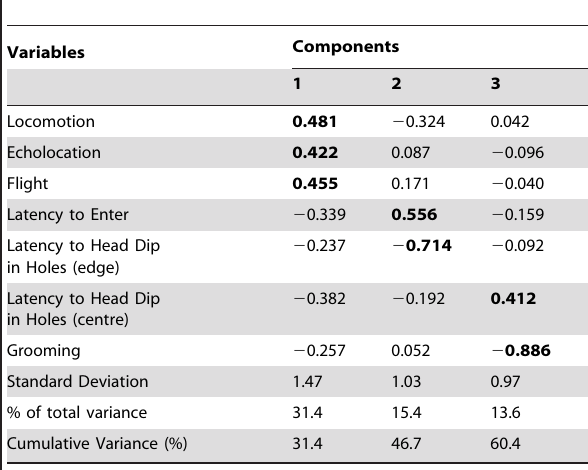
Table 1. Results for Principal Component Analysis of behavioural responses of 76 little brown bats in a novel- environment